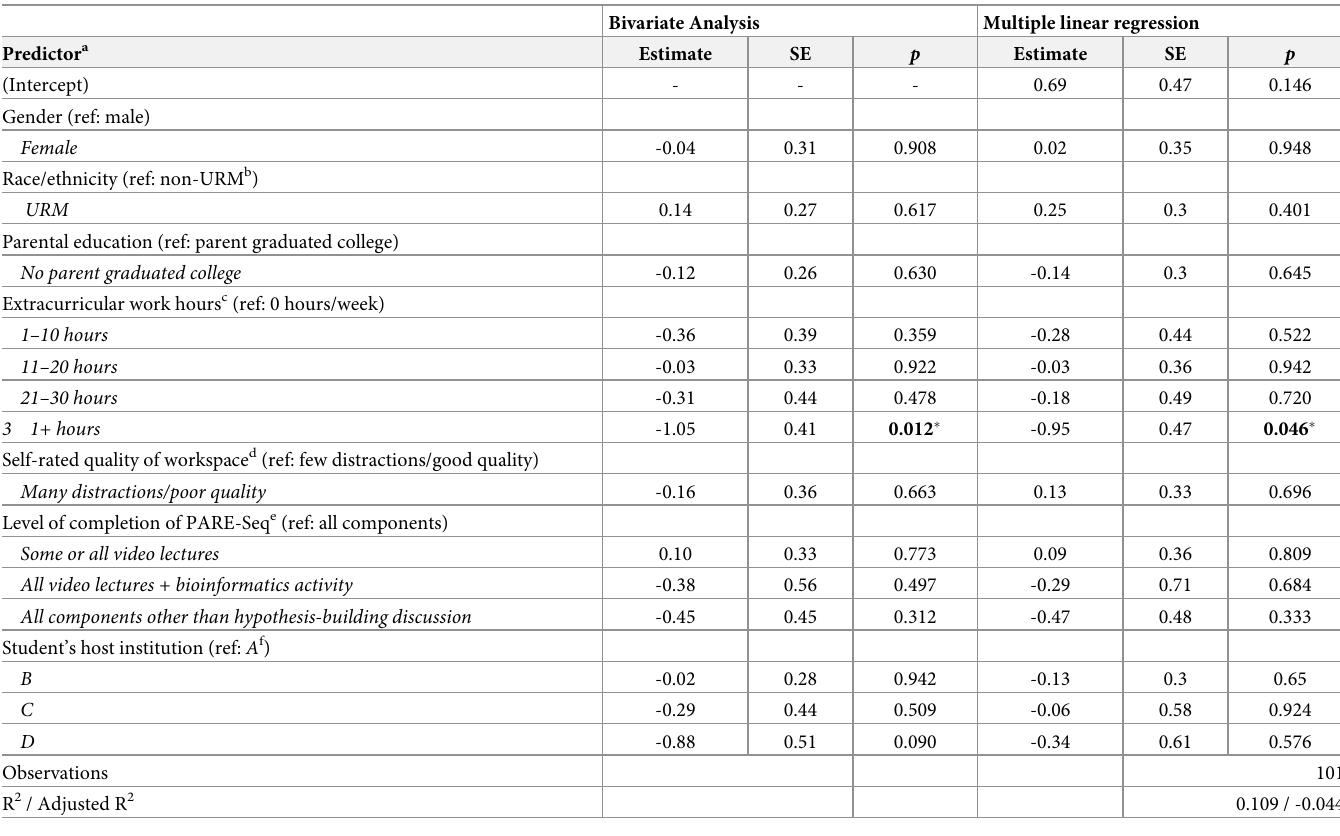
Table 8. Bivariate assotiations and multiple linear regression model of the effect of student sociodemographic characteristics on STEM Identity score